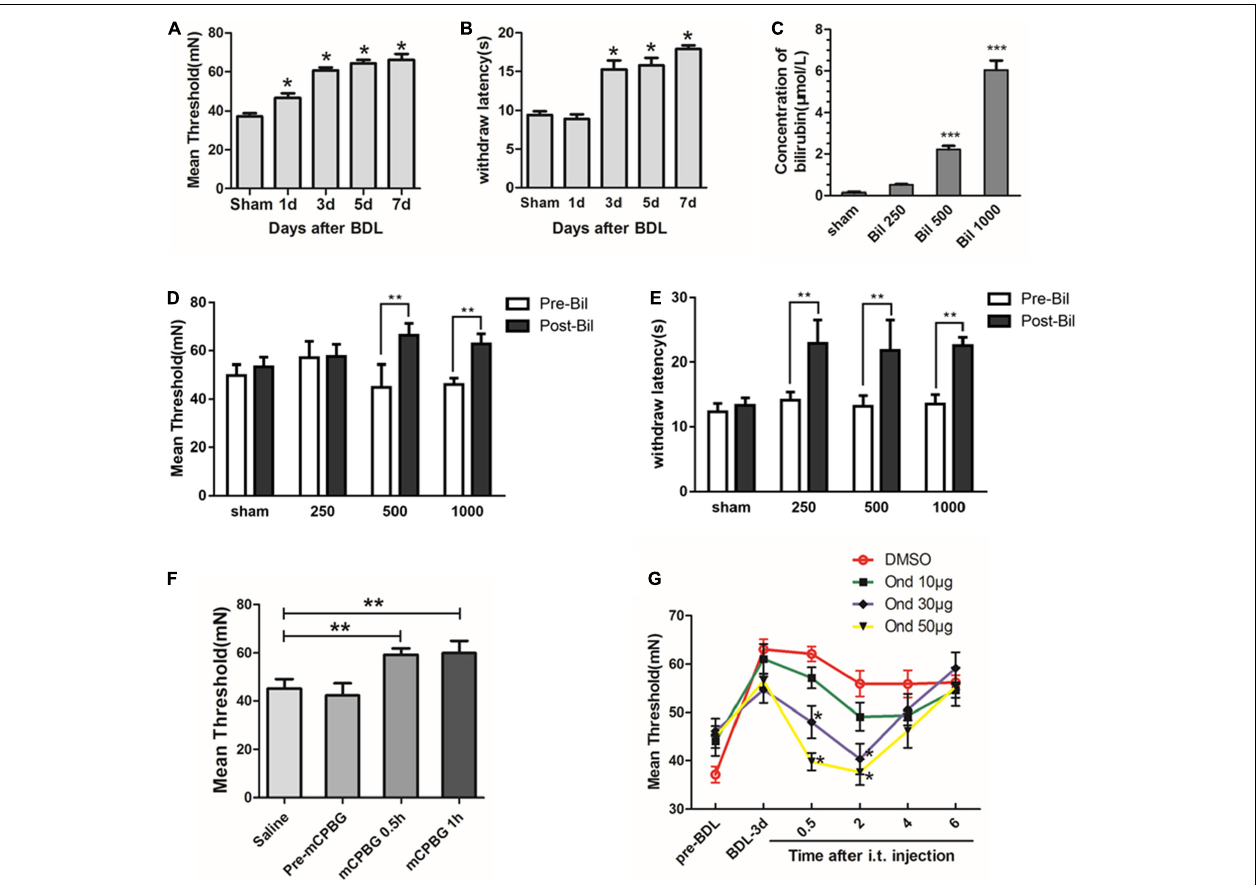
FIGURE 1 | Bilirubin increased pain threshold of cholestasis rats by activating the 5-HT 3 A receptor. (A) Mechanical pain threshold increased significantly in BDL rats on days 1, 3, 5, and 7 compared with sham group. (B) Thermal pain threshold increased significantly in BDL rats on days 3, 5, and 7 compared with sham group. (C) Indirect bilirubin level in CSF increased 20 min after intrathecal administration of bilirubin. (D) Mechanical pain threshold increased by 48 and 36% at 500 and 1000 µ M after administrating bilirubin intrathecally, respectively. (E) Intrathecal administration of bilirubin increased the thermal withdrawal latency by 62, 65.2, and 66.9% at 250, 500, and 1000 µ M, respectively. (F) Intrathecal administration of mCPBG—5-HT 3 A receptor agonist—increased mechanical threshold in normal rats compared with intrathecal administration of saline. (G) Intrathecal administration of ondansetron—a 5-HT 3 A receptor antagonist—reversed the increase of mechanical pain threshold in BDL-3-day rats in a dose-dependent manner. * P < 0.05; ** P < 0.01; *** P < 0.001.